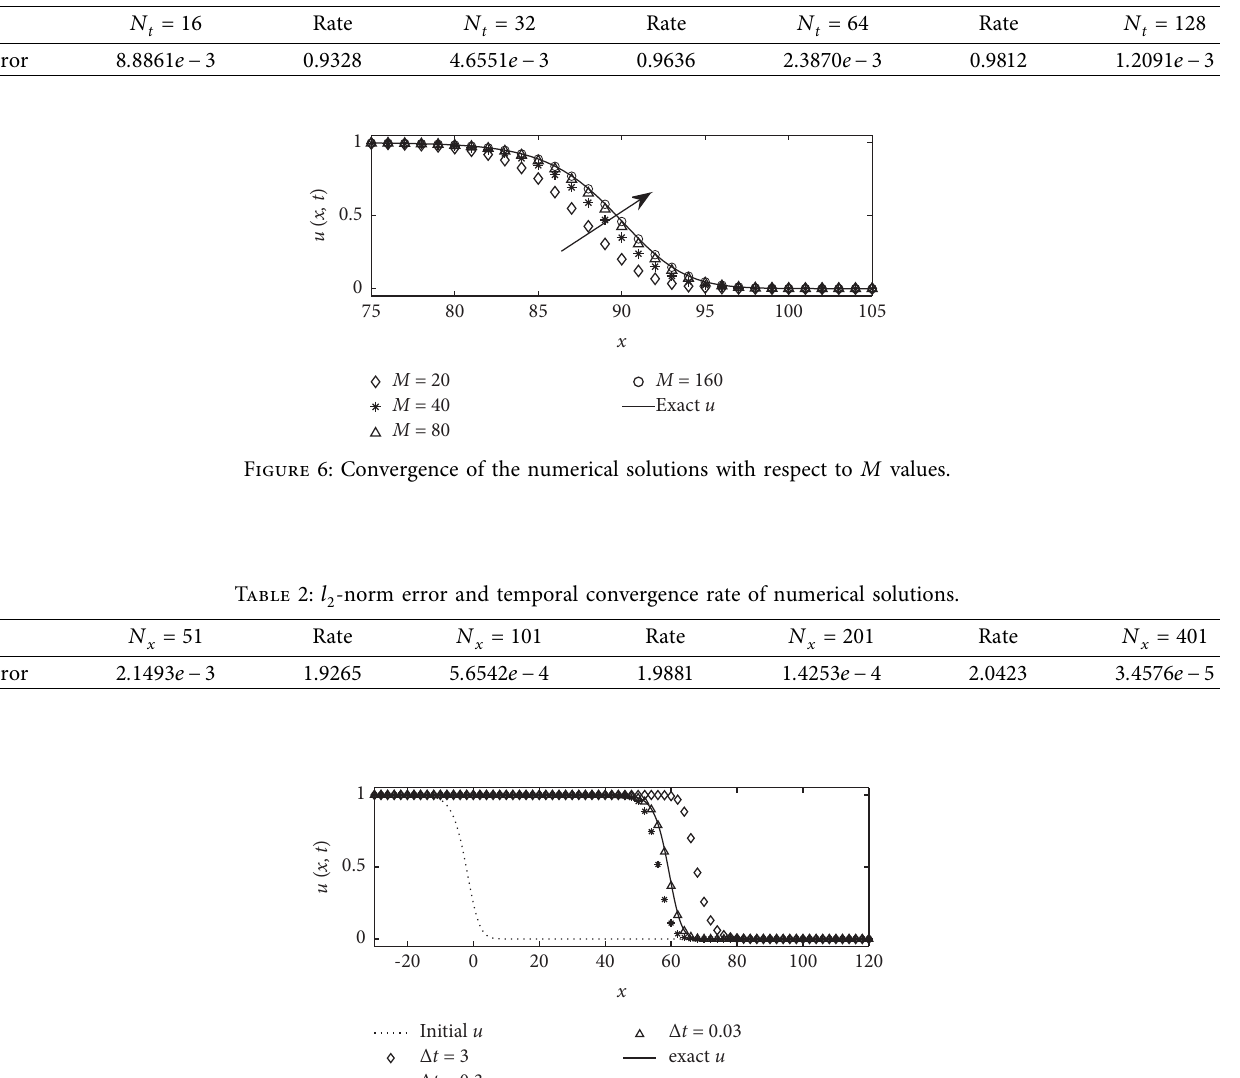
Table 1: l -norm error and temporal convergence rate of numerical solutions. 2